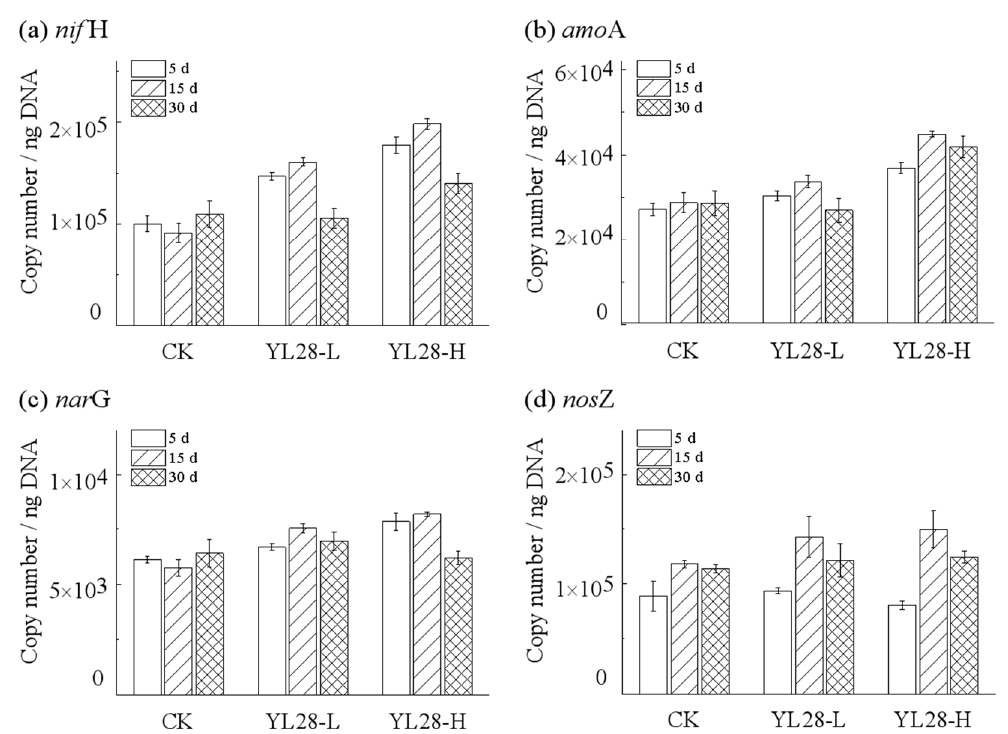
Figure 6. The relative abundance of functional genes involves in nitrification and denitrification during solid waste decomposition. nif H: nitrogenase gene ( a ); amo A: ammonia monooxygenase gene ( b ); nar G: nitrate reductase gene ( c ); nos Z: nitrous-oxide reductase Z gene ( d ). These functional genes were predicted by PICRUSt.